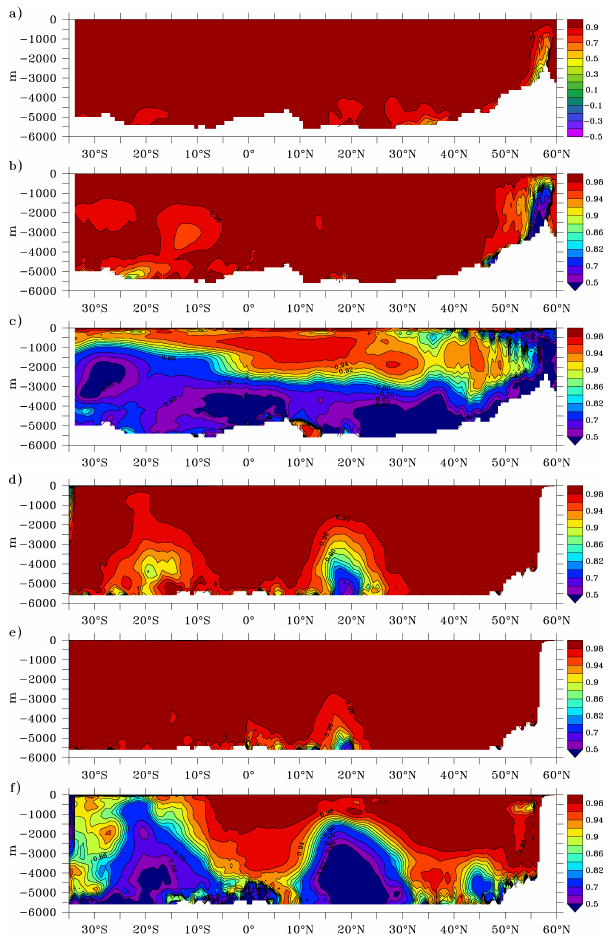
Figure 10: Correlations between the MOC in the NEMO simulations A100 and B100 for the 1976 to 2001 Fig. 10. Correlations between the MOC in the NEMO simulations period. a,b,c) Correlations for the unfiltered Atlantic MOC for unfiltered (5-day averages) (a) subannual A100 and B100 for the 1976 to 2001 period. (a) , (b) , (c) Correla- (b) and interannual (c) MOC variability. d,e,f): As panels a,b,c but for the Indo-Pacific basin. For tions for the unfiltered Atlantic MOC for unfiltered (5-day averages) correlations higher (lower) than 0.8 the contour interval is 0.02 (0.1). (a) subannual (b) and interannual (c) MOC variability. (d) , (e) , (f) As panels (a) , (b) , (c) but for the Indo-Pacific basin. For correlations higher (lower) than 0.8 the contour interval is 0.02 (0.1).